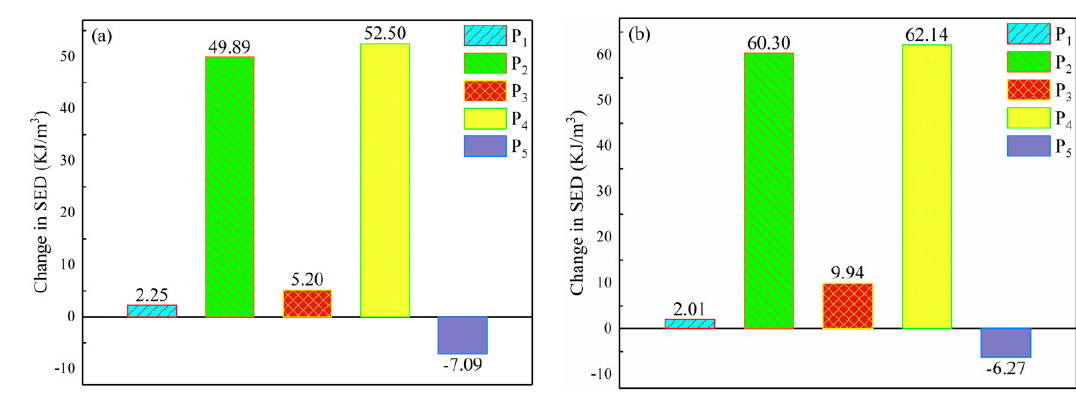
Figure 12. Changes in SED ( a : model I; b : model II).